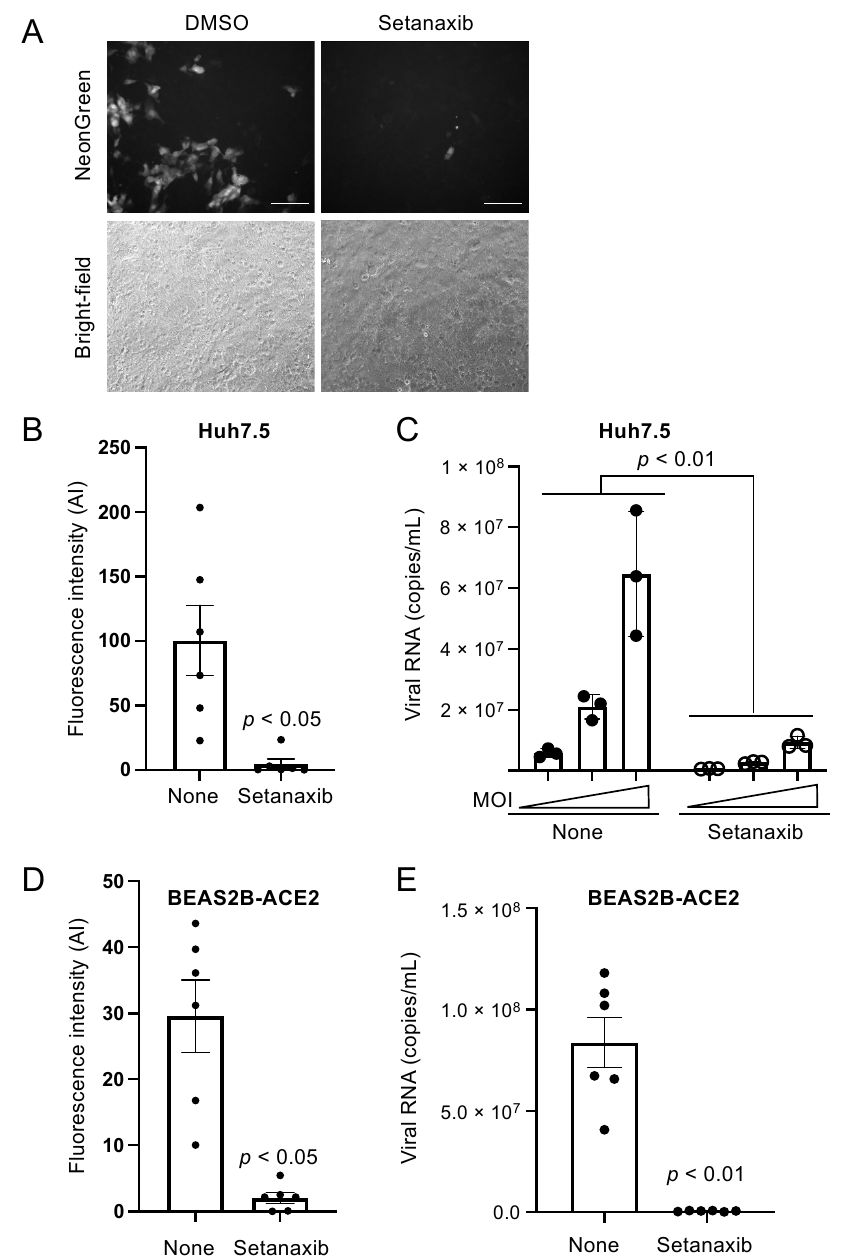
Figure 5. Inhibition of SARS-CoV-2 replication by Setanaxib. ( A , B ) Huh7.5 cells were treated for 24 h with Setanaxib (25 µ M) or left untreated, and then infected with recombinant SARS-CoV-2 expressing mNeonGreen (MOI = 0.1). After 24 h of culture, infection was determined by fluorescence microscopy. A representative image is presented in ( A ). Scale bar is 100 µ m. A total of six randomly selected microscopy fields from three independent culture wells (one experiment in triplicate) were analyzed for mNeonGreen expression. Fluorescence quantification was performed with ImageJ, and corresponding data are presented in ( B ). ( C ) Same as in ( A ) but cells were infected with recombinant SARS-CoV-2 expressing mNeonGreen at 0.004, 0.02 and 0.1 MOIs. After 24 h of culture, supernatants were harvested and SARS-CoV-2 RNAs were quantified by RT-qPCR. ( D ) Beas-2B cells expressing ACE2 were infected with SARS-CoV-2 expressing mNeonGreen (MOI = 0.004) and cultured without or with Setanaxib at 25 µ M. After 48 h, infection was determined by fluorescence microscopy for mNeonGreen expression. Quantitative data correspond to the fluorescence signal from six independent culture wells obtained with ImageJ (two independent experiments in triplicate). ( E ) Same experiment as in ( D ) but culture supernatants were collected to quantify viral RNA by RT-qPCR. Data correspond to means ± SEM. Statistical significance was determined by Student’s t -test using Prism (GraphPad Software, San Diego, CA, USA) for all panels except ( C ) where two-way ANOVA was